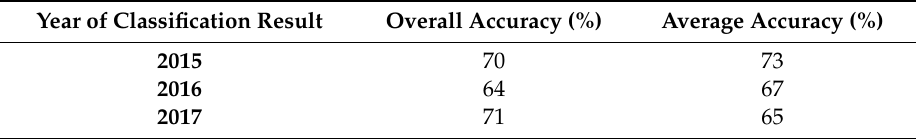
Table 7. Leave one year out method accuracy assessment